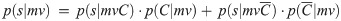
Mixture model.The presaccadic location of the NT (square) is reported after a transsaccadic displacement of 10° to the right. Objects in red represent visible targets; the white objects depict the veridical target locations. Representations of location estimates, modeled as 2D Gaussians, are shown as dark ellipses. (A) Before the saccade, all three objects are encoded with the foveal prior f (light grey blob) being centered at the triangle, the FT. After the saccade, the displaced target’s position and identity (NT here) are encoded with f now being centered at the saccade landing position. (B) Based on the NT’s presaccadic (m) and postsaccadic (v) representations, both biased by f, the probability of a single stable object, p(C|mv), is computed. In case m and v are unrelated the best solution is to segregate and ignore v. If m and v derive from the same object, the best solution is to integration all signals. (D) The two solutions in (C) are weighted according to the probability that m and v are related. The localization response follows from p(s|mv)=p(s|mvC)⋅p(C|mv)+p(s|mvC¯)⋅p(C¯|mv).